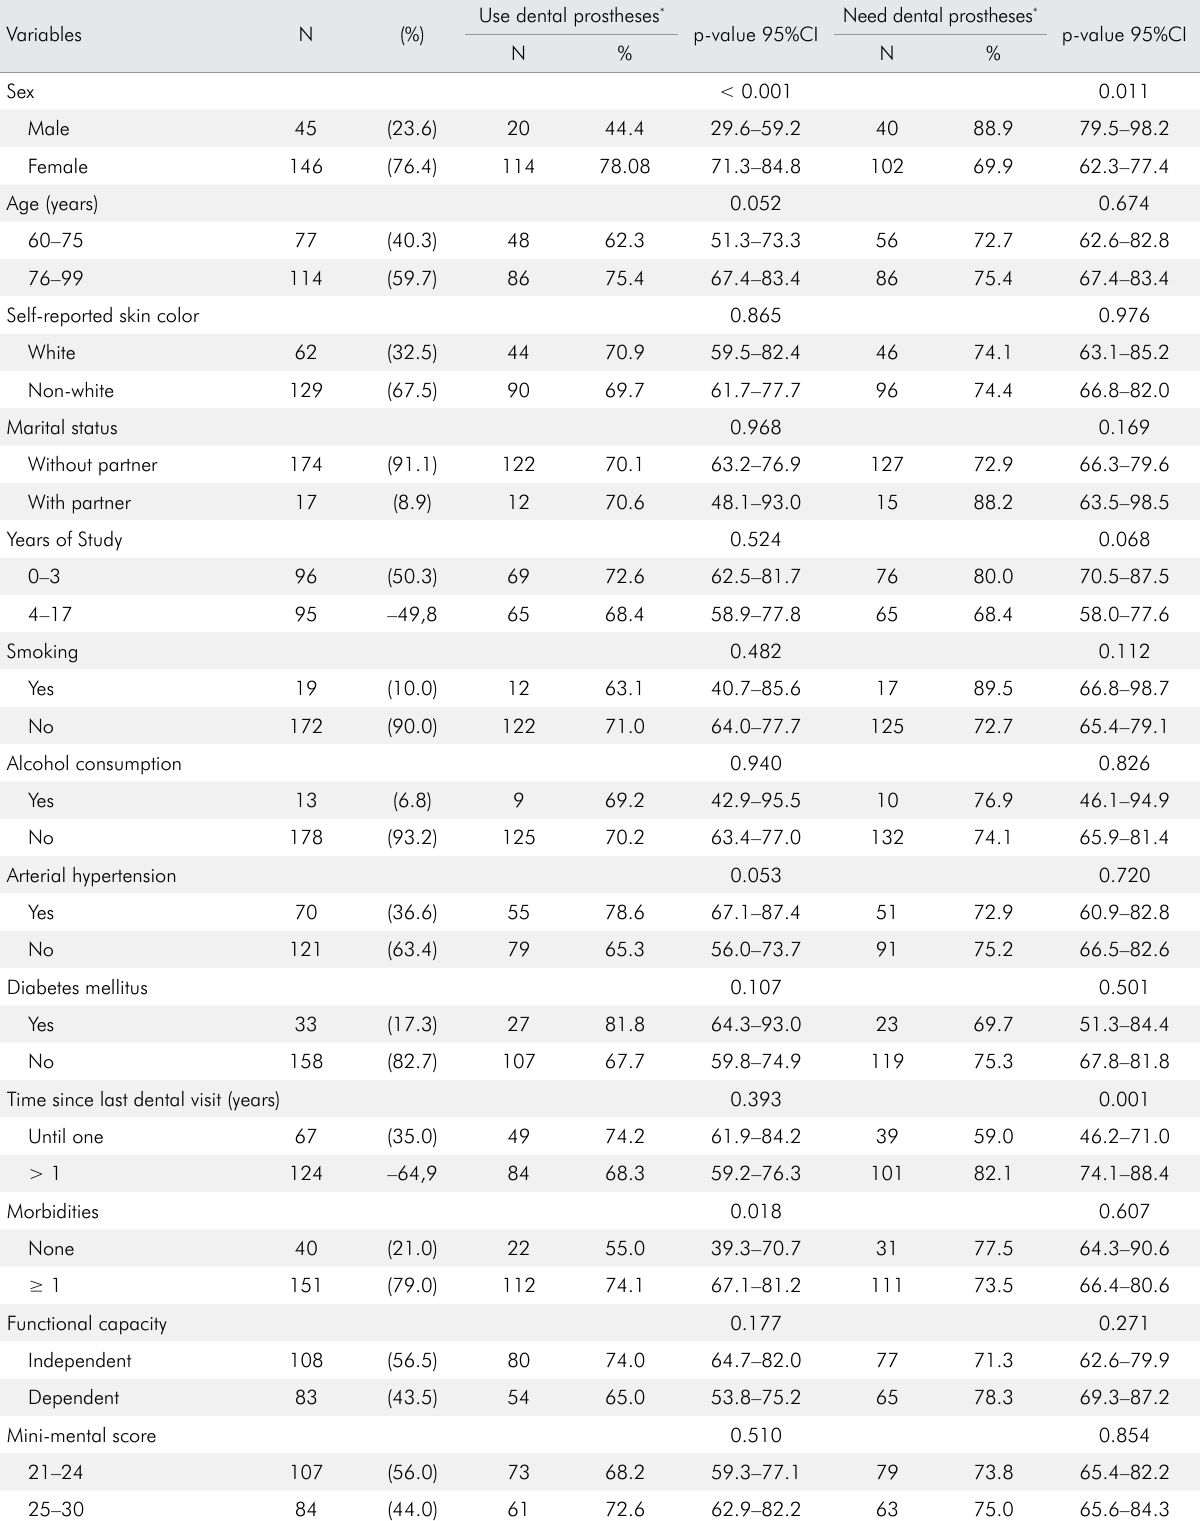
Table 1. Sample characteristics and association between exposures and outcomes of use and need of dental prostheses in institutionalized elderly